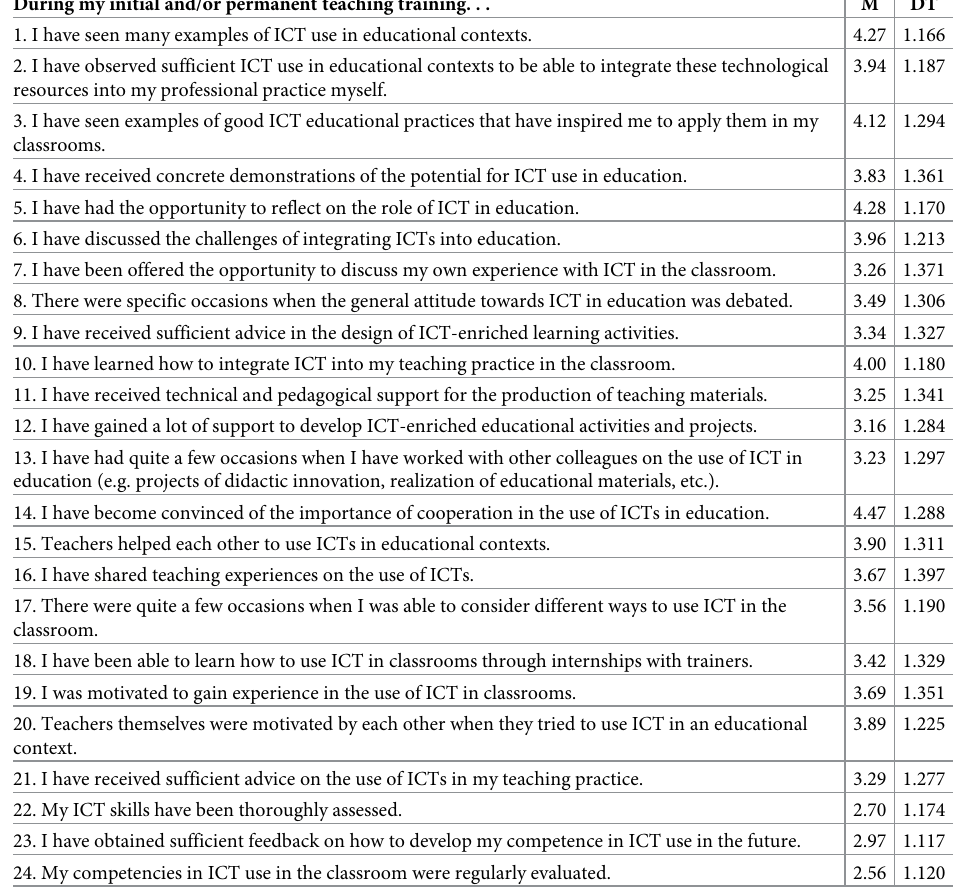
Table 3. Description of the initial and/or permanent teaching training experience (SQD scale). During my initial and/or permanent teaching training. .